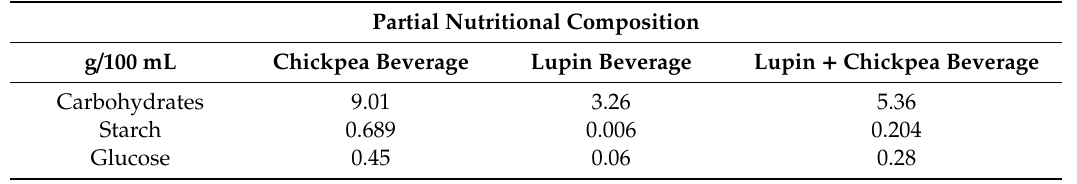
Table 3. Carbohydrates, including starch and glucose contents in pulse beverages obtained from the processing procedure B-whole seeds, colloidal milling and without the cooking